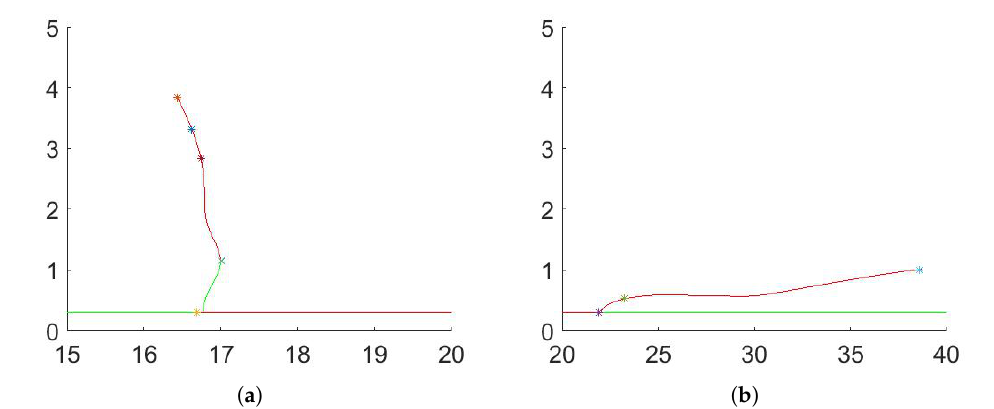
Figure 17. Periodic solutions from Hopf bifurcation ( ∗ ) at different values of τ for the system (1), ( a ) τ = 16.7676; and ( b ) τ = 22.0586; at E 1 = ( 0.1,0.39,2.62,11.41 ) . Stability switching occurred from stable (green line) to unstable (red line) and vice versa.